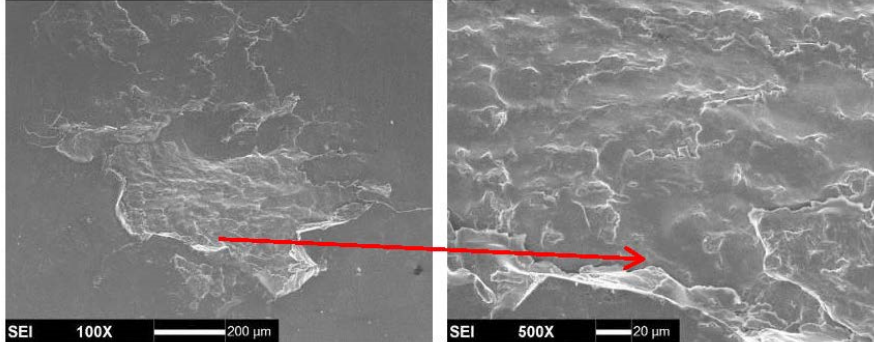
Figure 9. Microscopic morphologies of the spalling position of the inner ring raceway.